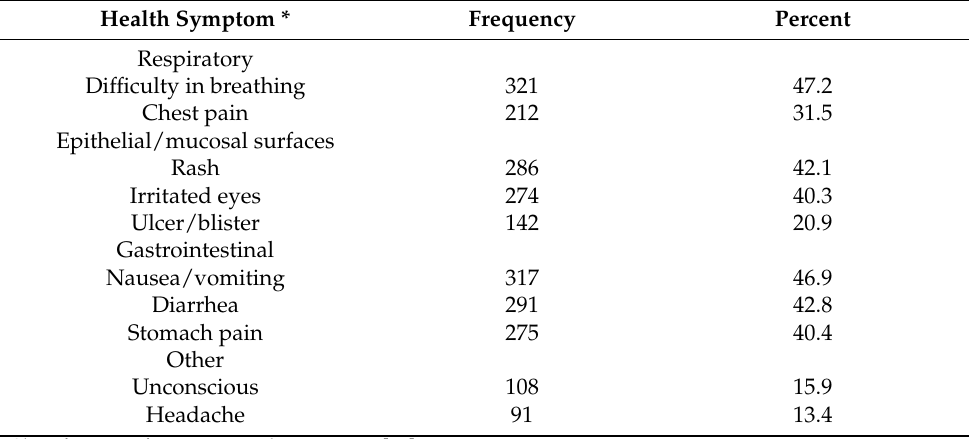
Table 5. Prevalence of acute health symptoms among farmers in Nakhon Sawan (N = 680).